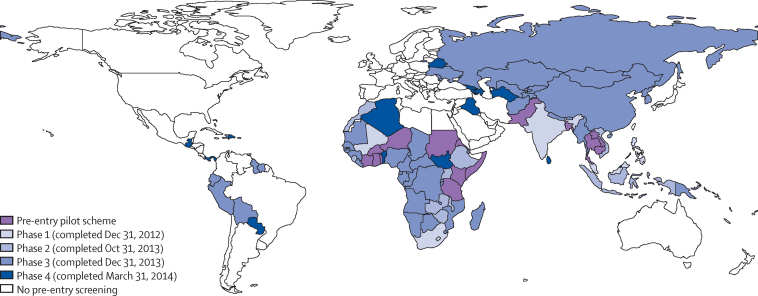
Locations of pre-entry screening sitesIncludes both International Organization for Migration sites and other sites. The pre-entry pilot scheme was done in Bangladesh, Burkina Faso, Cambodia, Côte d'Ivoire, Eritrea, Ghana, Kenya, Laos, Niger, Pakistan, Somalia, Sudan, Tanzania, Thailand, and Togo. Pre-entry screening was subsequently rolled out to 101 countries in four phases between May, 2012, and March 31, 2014.